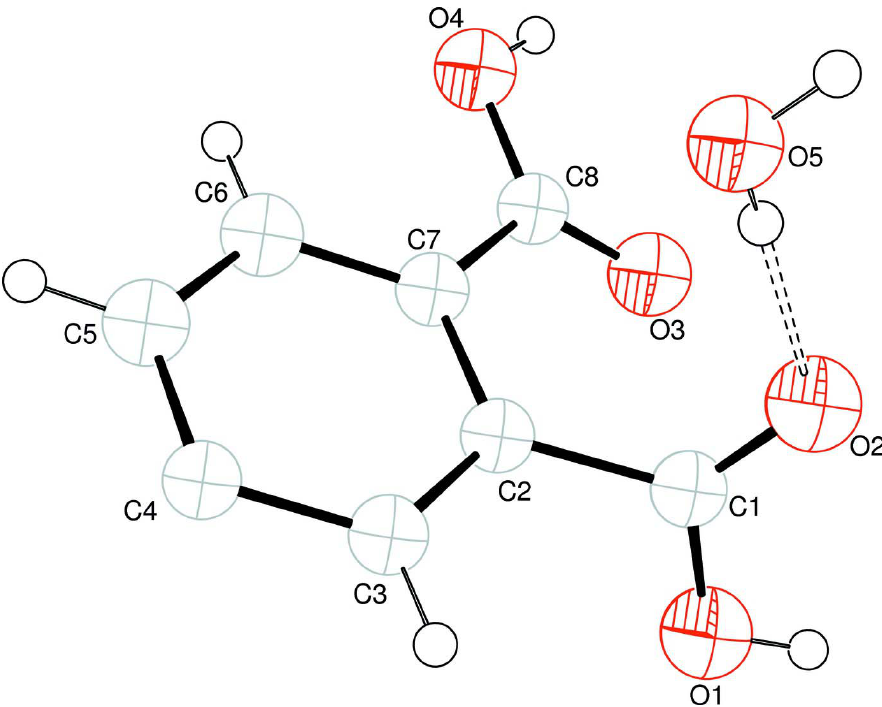
Figure 1 The asymmetric unit of the title molecule with the atom-numbering scheme. Hydrogen bond is shown as dashed line.